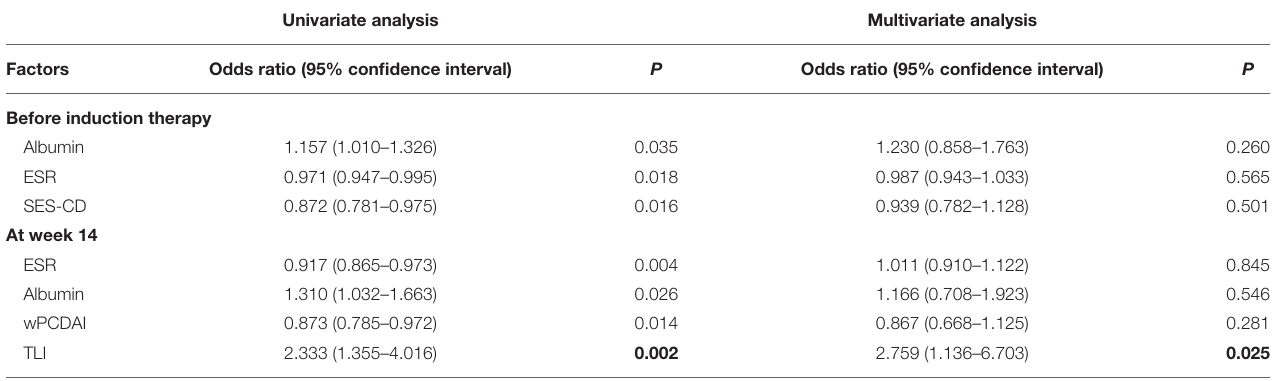
TABLE 3 | Factors associated with mucosal healing at week 30. Univariate analysis Multivariate analysis